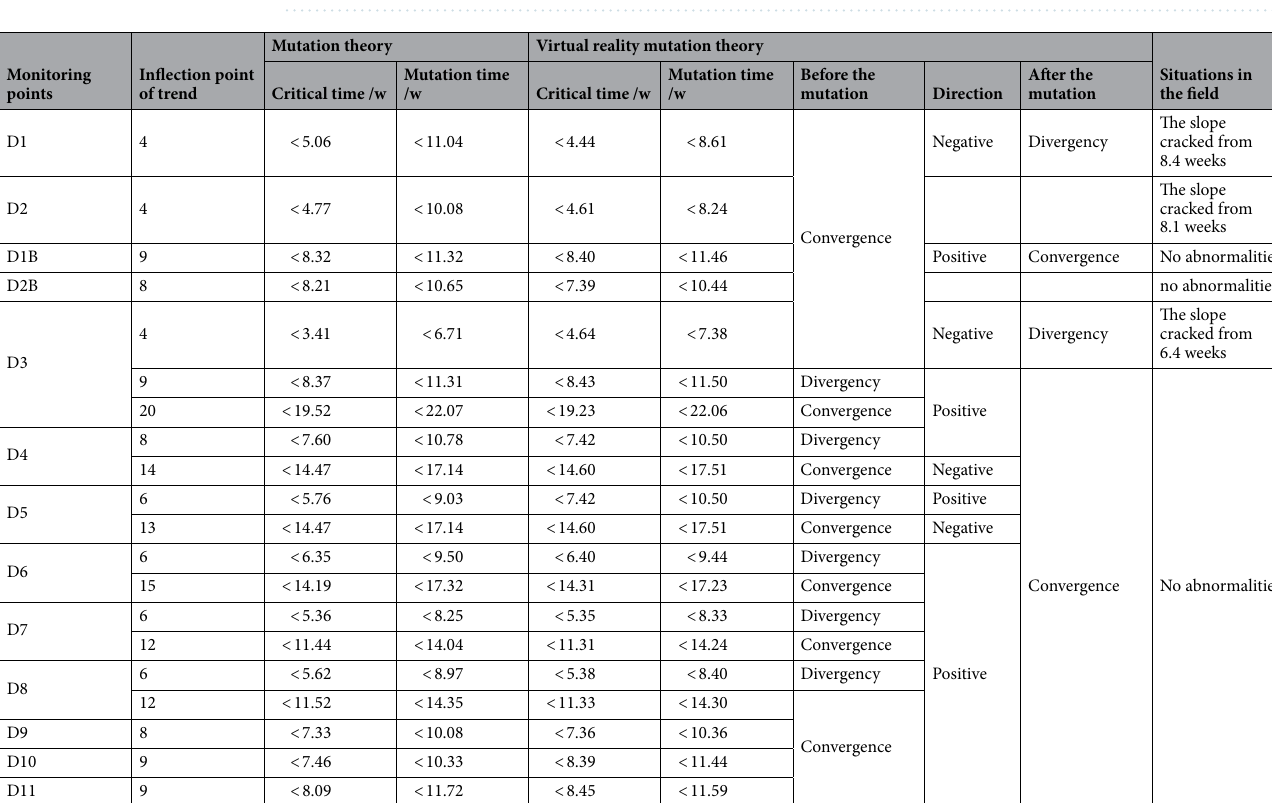
Table 5. Comparison table of deformation and mutation time at each monitoring point. The critical time and mutation time of each monitoring point in the table are calculated by taking the starting time of each monitoring point as the initial zero